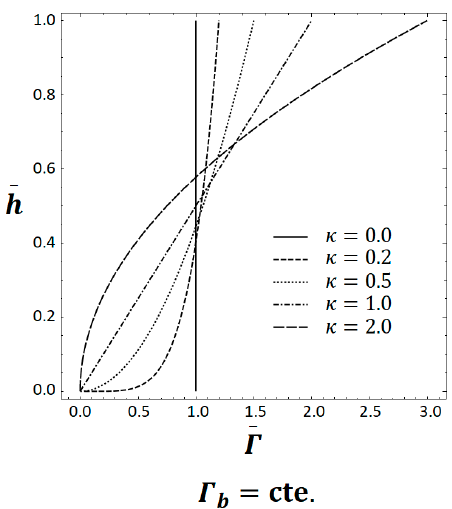
Figure 2. Variation of the dimensionless GPL weight fraction ( Γ = Γ ( z ) / Γ b ) through the thickness of the top face sheet with respect to various power-law parameters ( h = ( 2 z − h c ) /2 h f Therefore, the elastic modulus for the (cid:1863) th layer can be expressed as